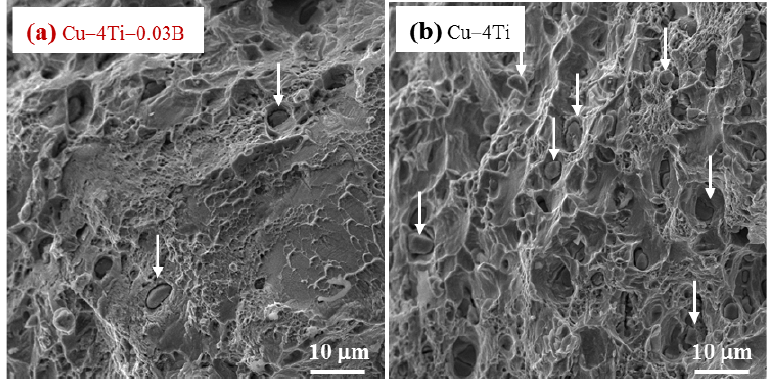
Figure 6. FE-SEM images of the fracture surfaces of ( a ) Cu–4Ti–0.03B and ( b ) Cu–4 Ti alloys that were aged at 450 °C for 72 h. The arrows in ( a ) and ( b ) indicate representative Ti inclusions. β -Cu 4